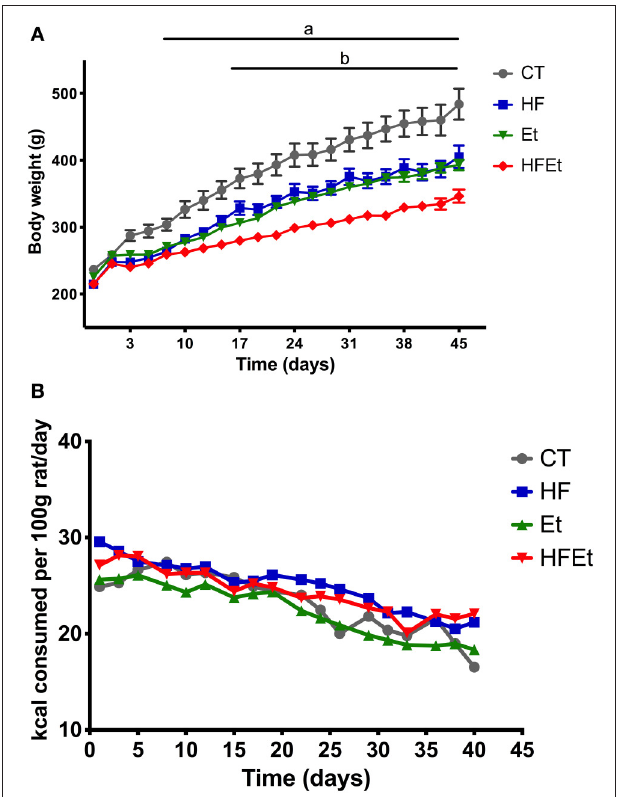
FIGURE 1 | Body weight (A) and food intake (B) of rats fed with control diet (CT), high fructose diet (HF), ethanol (Et), or a mix (HFEt) during 6 weeks. Values are mean ± SEM ( n = 8/diet for each time point). a: Statistical difference between CT vs. HF, Et, and HFEt from the 10th day until the end of the protocol. b: Statistical difference between HFEt vs. HF and Et from the 17th day until the end of the protocol.